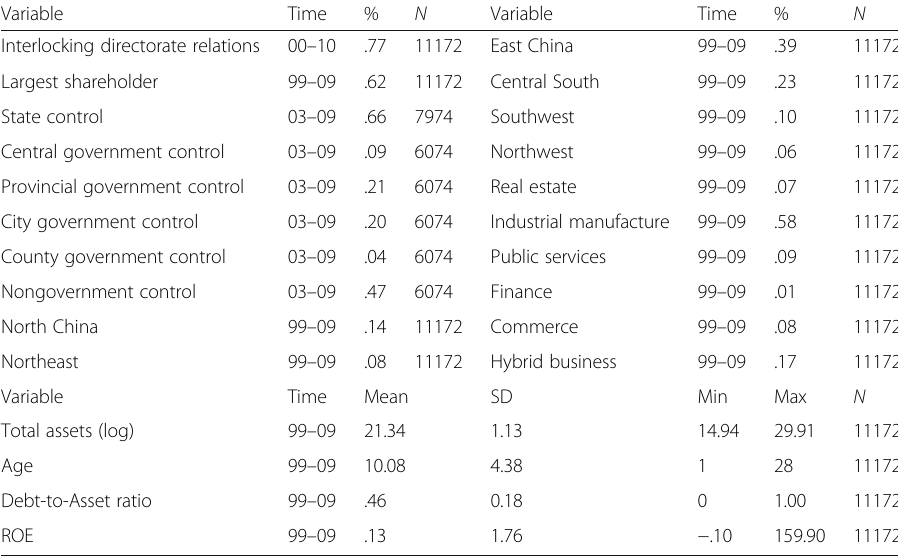
Table 1 Descriptive statistics of all individual level variables